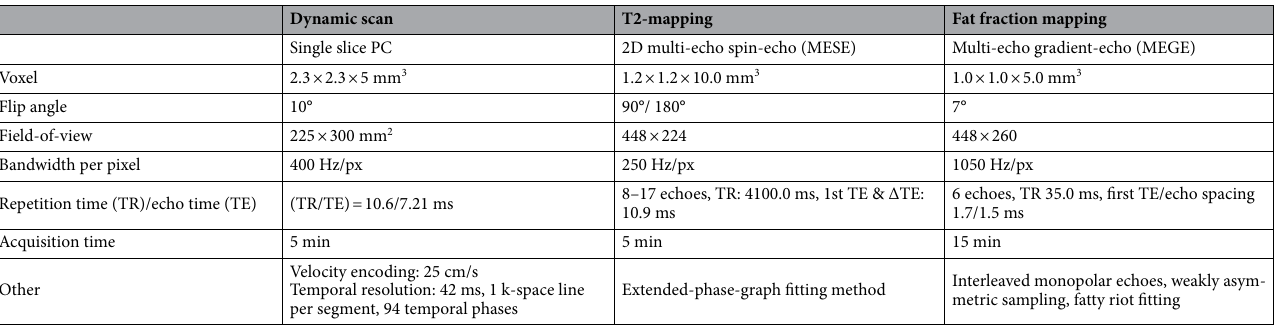
Table 1. MRI parameters for dynamic and quantitative